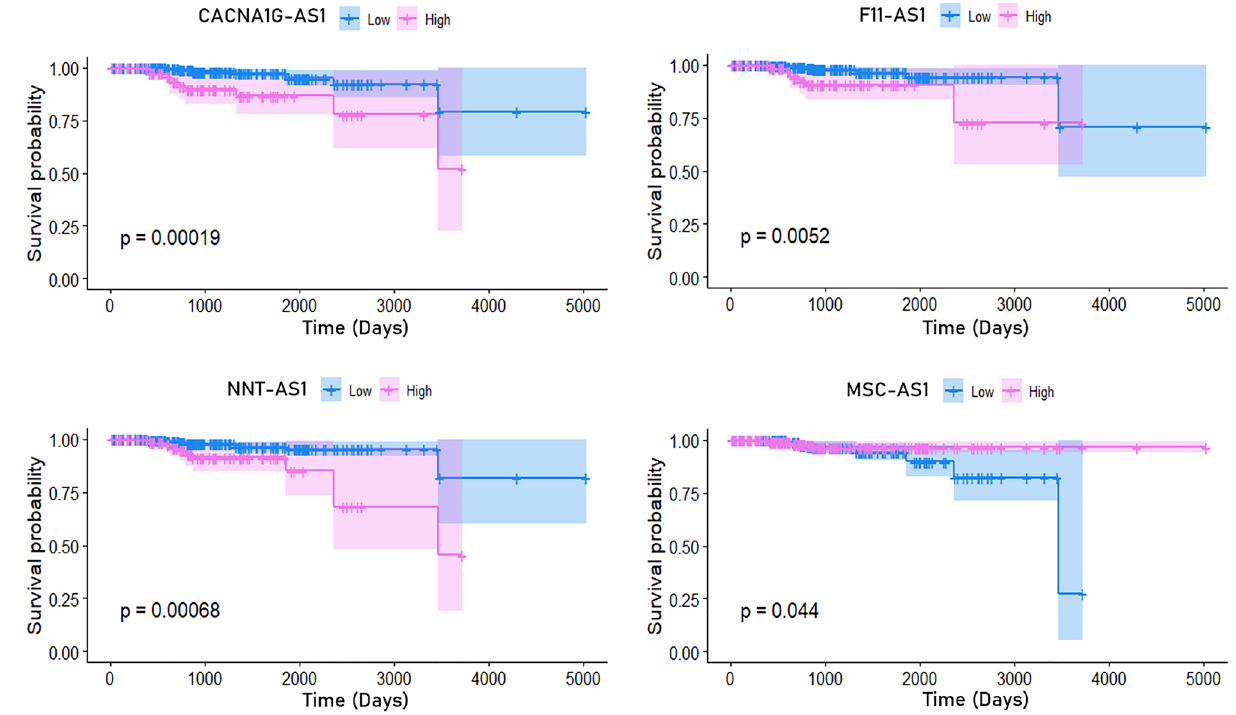
Figure 6. Overall survival analysis of the patients with prostate cancer based on the expression of CACNA1G-AS1, F11-AS1, NNT-AS1, and MSC-AS1. Median FPKM value was considered as cut-off value.